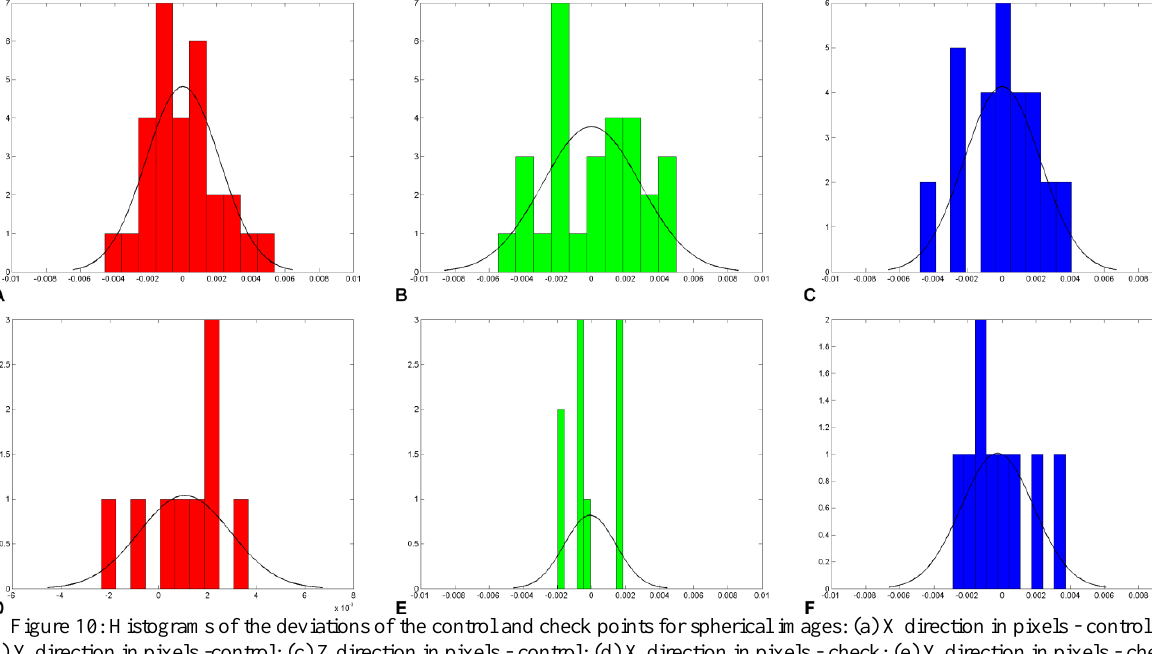
Figure 9: Histograms of the deviations of the control and check points for orthoimages: (a) X direction in pixels - control; (b) Y direction in pixels - control; (c) Z direction in pixels - control; (d) X direction in pixels - check; (e) Y direction in pixels - check; (f) Z direction in pixels – check.